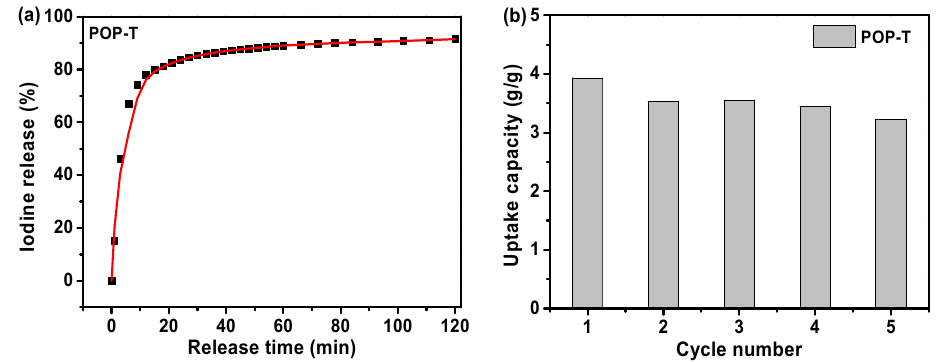
Figure 5. ( a ) The iodine released from I 2 @POP-T into methanol, ( b ) Cyclic stability of POP-T.